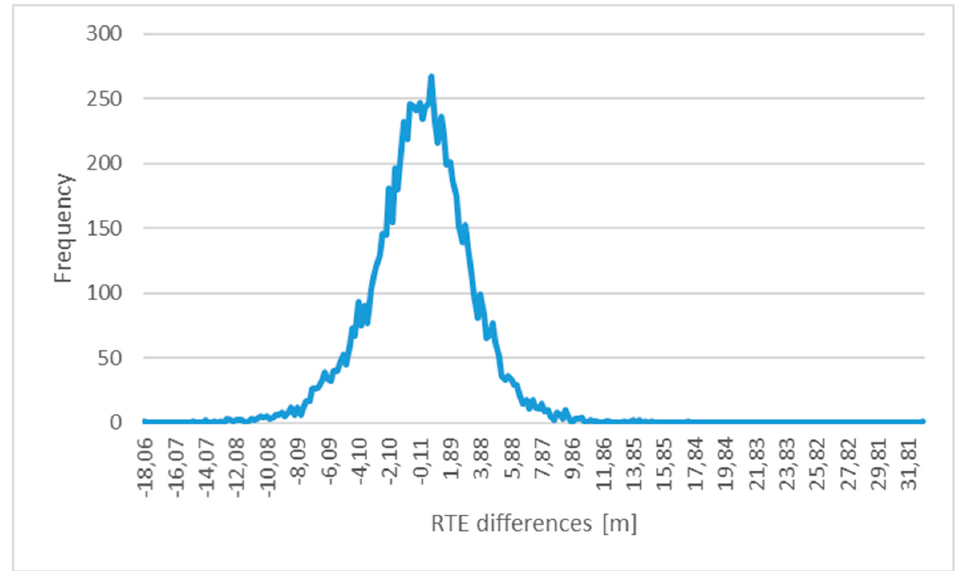
Figure 5. Histogram of the PSI and TomoSAR RTE differences.